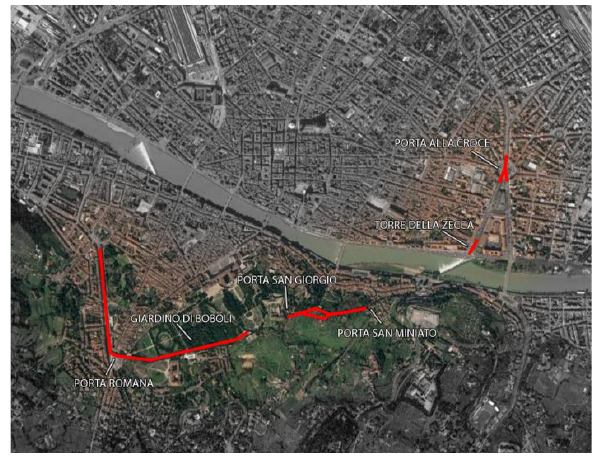
Figure 2. Framing surviving wall sections affected by the FI- MU project.